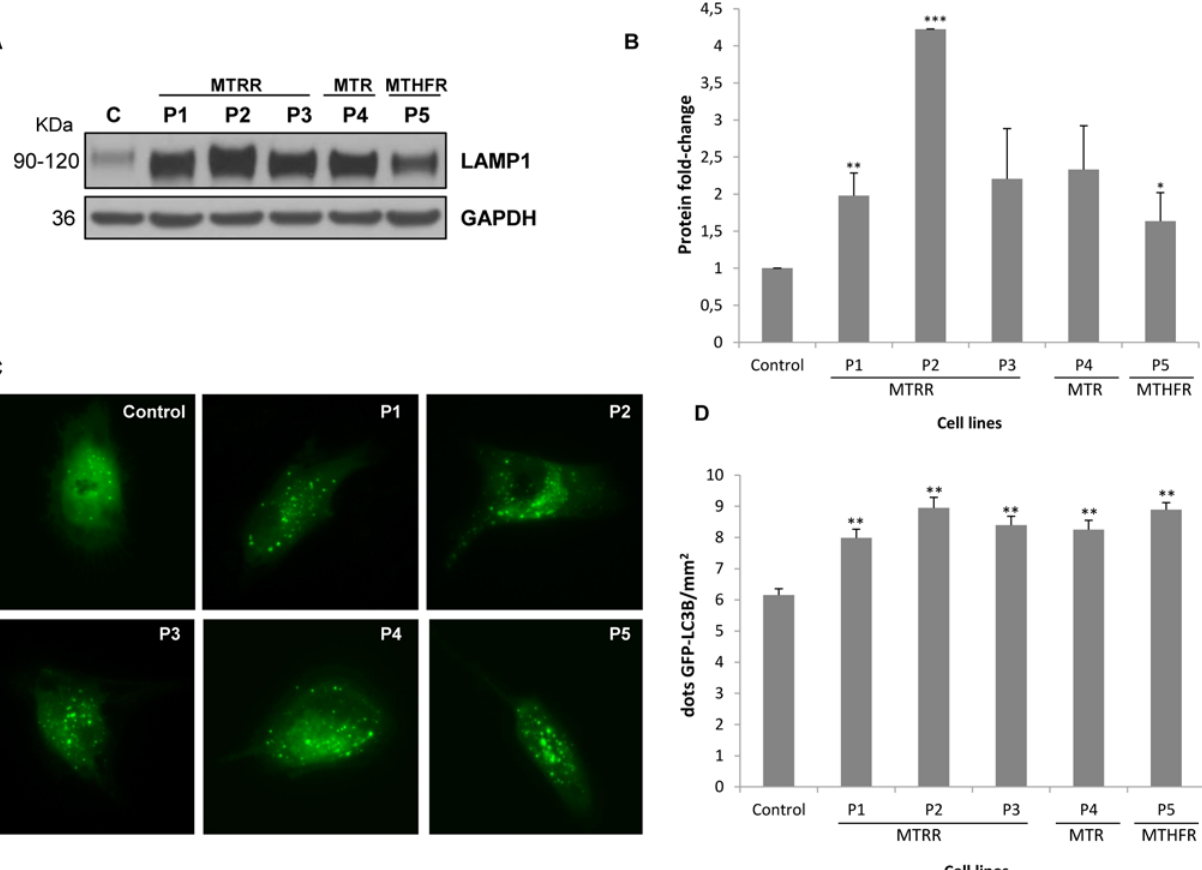
Fig 6. Analysis of autophagy process in patients-derived fibroblasts with homocystinuria. (A) Analysis of protein levels by immunoblotting. Equal amounts from control and the five patients were loaded (50 μ g of total cell lysates) and subjected to Western Blot with anti-LAMP1 antibody. We used anti- GAPDH antibody to ensure equal amounts of protein loaded in each lane. This result is representative of three independent experiments. (B) Protein quantification was performed by laser densitometry. The ratios between proteins/GAPDH for each cell line were calculated to determine the expression fold- change relative to control. Data represent mean ± standard deviation of three independent experiments. (C) Analysis of autophagosomes formation by fluorescence microscopy. Representative images of the autophagosome monitorization in control and patients-derived fibroblasts. (D) Quantification of autophagosome number per area in patients´cells compared to control. Results were obtained from three independent experiments. Data represent ffiffiffiffiffi p 80 mean ± SEM (standard error of the mean = SD/ ) of positive fl uorescence points of LC3B in each mm 2 of 80 cells analysis. * P < 0.05; ** P < 0.01; *** P < 0.001.